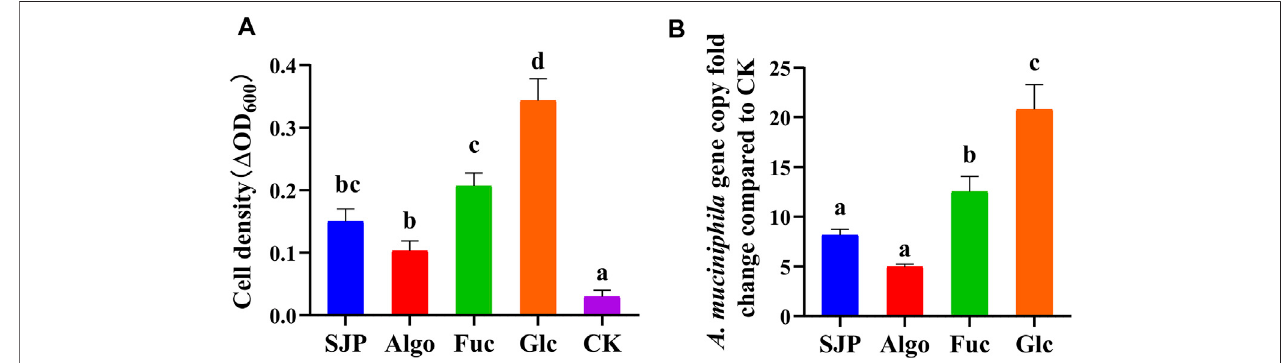
FIGURE8 | Growth of Akkermansia muciniphila inmodi fi ed PYG medium in the presence ofSJP, alginate oligosaccharides (Algo), fucose(Fuc), and glucose (Glc). The control condition (CK) was achieved by excluding the addition of experimental substances. (A) Changes in OD 600 in each culture group. (B) Fold change in the A. muciniphila gene copy in each group relative to CK. Results are shown as mean ± SD ( n (cid:2) 3). a,b,c,d Signi fi cant differences were analyzed using one-way ANOVA with post-hoc Tukey HSD test for multiple group comparisons ( p < 0.05). PYG, peptone – yeast extract – glucose; SJP, seaweed Laminaria japonica polysaccharides; HSD, honestly signi fi cant